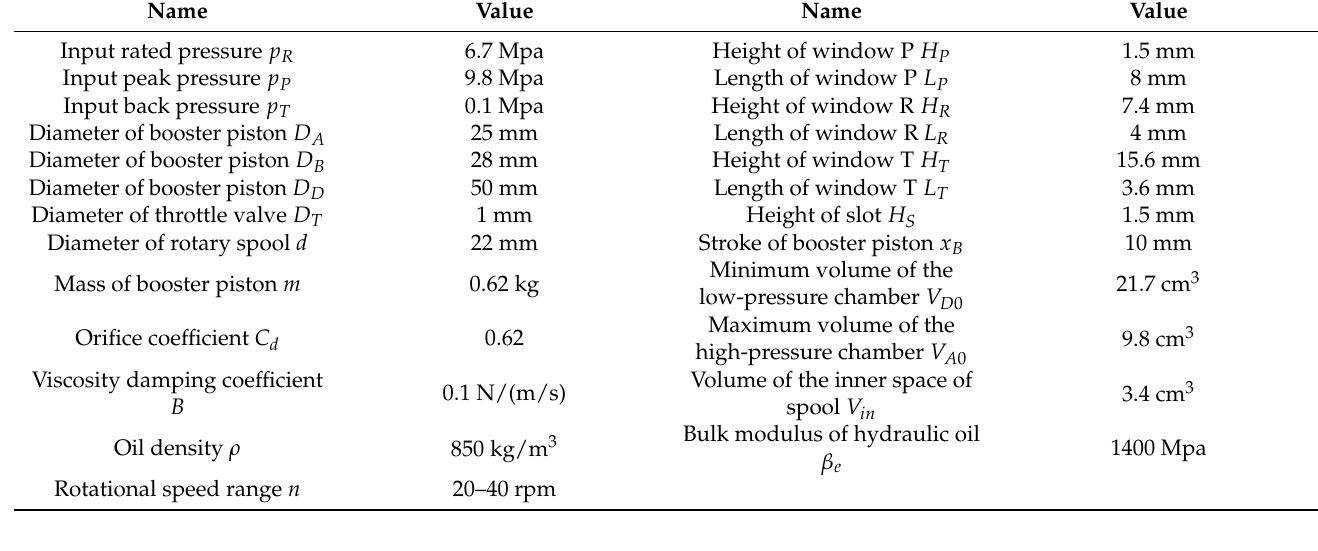
Table 1. Critical parameters.